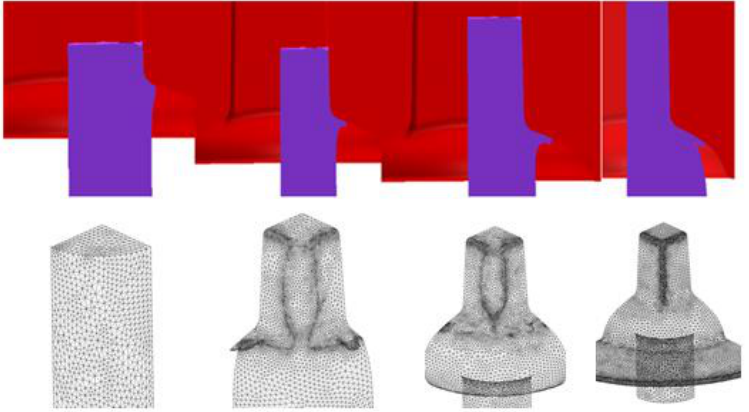
Figure 7. Sequence of fold formation at the cap of the head of the screw spike.